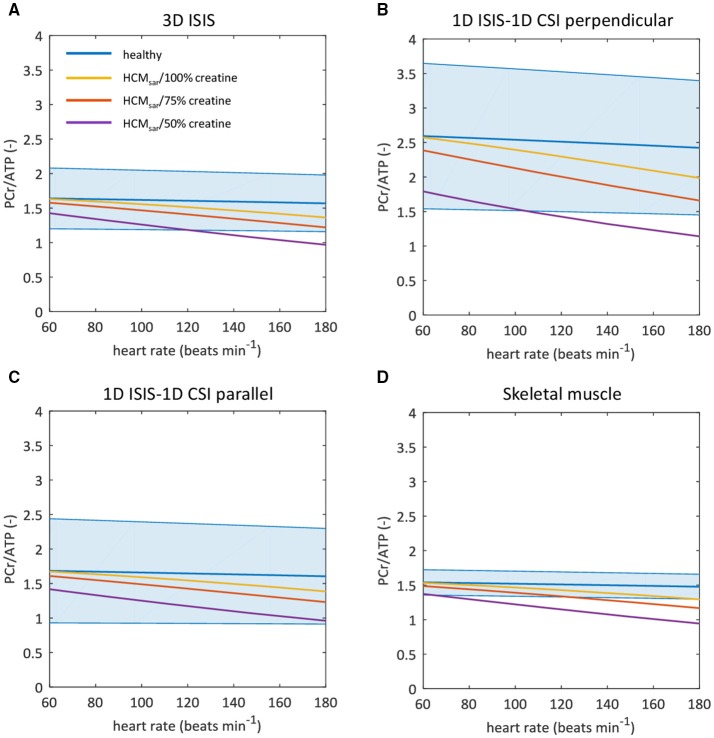
Sarcomeric energy inefficiency results in lower myocardial PCr/ATP ratios compared to the healthy myocardium. Graphs show computational model-based predictions of the myocardial PCr/ATP ratio over a range of cardiac work rates for the healthy heart (blue) and for hypertrophic cardiomyopathy due to sarcomeric energy inefficiency (HCMsar) with 100% (yellow), 75% (red), and 50% (purple) of the normal creatine pool size. The solid curve represents the mean of the simulation results while the shaded region reflects the model uncertainty (95% confidence intervals). Resting-state mean and confidence intervals are based on empirical 31P-MRS measurements and associated coefficients of variation for 3D ISIS (A), 1D CSI in a 1D ISIS-selected slice perpendicular to the surface coil (B), 1D CSI in a 1D ISIS-selected slice parallel to the surface coil (C), and for the improved measurement precision of 31P-MRS in calf skeletal muscle but assuming the mean PCr/ATP ratio found with 3D ISIS (D). ATP, adenosine triphosphate; CSI, chemical shift imaging; ISIS, image-selected in vivo spectroscopy; PCr, phosphocreatine.